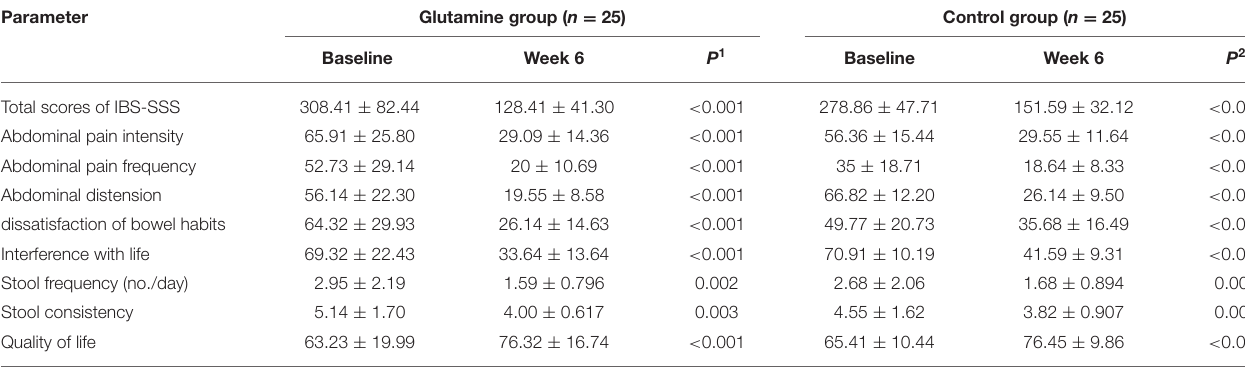
TABLE 3 | Gastrointestinal symptoms and quality of life in patients with irritable bowel syndrome.